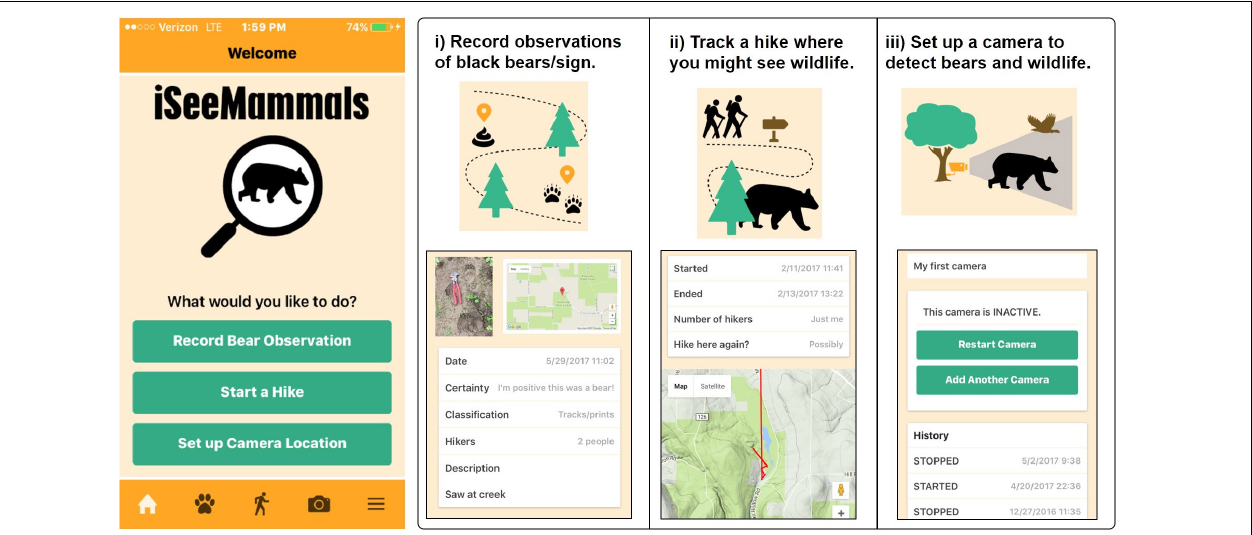
FIGURE 1 | Home screen of iSeeMammals smartphone app and the 3 ways to collect presence-only (PO) and presence-absence (PA) data on black bears in New York with observations, hikes, and camera traps. Users provide details, including time, location, and descriptions which can be viewed on the website and app. Some features can only be accessed with the app, including creation and tracking of a hike and recording the location of a camera trap. Other features can only be accessed with the website (not shown), including submission of camera trap